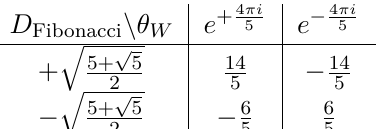
Table 1 . Central charges (mod 8 ) of the Fibonacci modular tensor category with d W = 1+